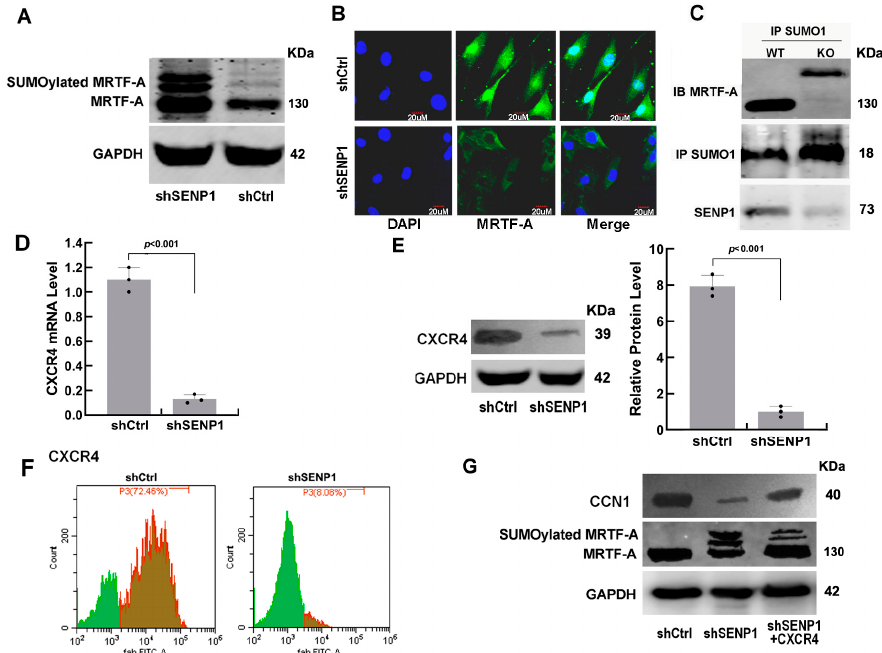
Figure 3. SUMO1 modification of MRTF-A after SENP1 knockdown, and the impact of CXCR4. ( A ) MRTF-A SUMOylation analyzed by Western blotting in hMSCs shSENP1 and hMSCs shCtrl after EDM-induced differentiation. ( B ) Immunofluorescence detection of MRTF-A cellular localization. ( C ) Co-immunoprecipitation analysis to determine the conjugation between MRTF-A and SUMO1. ( D , E ) The expression of CXCR4 in hMSCs shSENP1 and hMSCs shCtrl determined by mRNA level and protein expression. ( F ) The expression of CXCR4 analyzed by flow cytometry, which was represented by a green peak for CXCR4- cells and a red-brown peak for CXCR4+ cells. ( G ) Over-expressing CXCR4 partially abrogated the impact of SENP1 knockdown on MRTF-A SUMOylation and CCN1 expression. Quantitation is shown as the means ± SD ( p values are as indicated, n = 3. Individual data points were shown as scattered black dots).